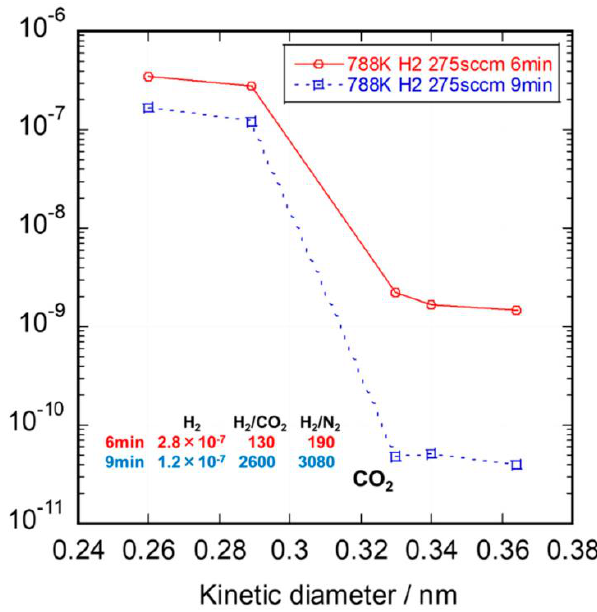
Figure 5. Single-gas permeance of SiC membranes formed by the CVD deposition process. Reprinted from [63] with permission.